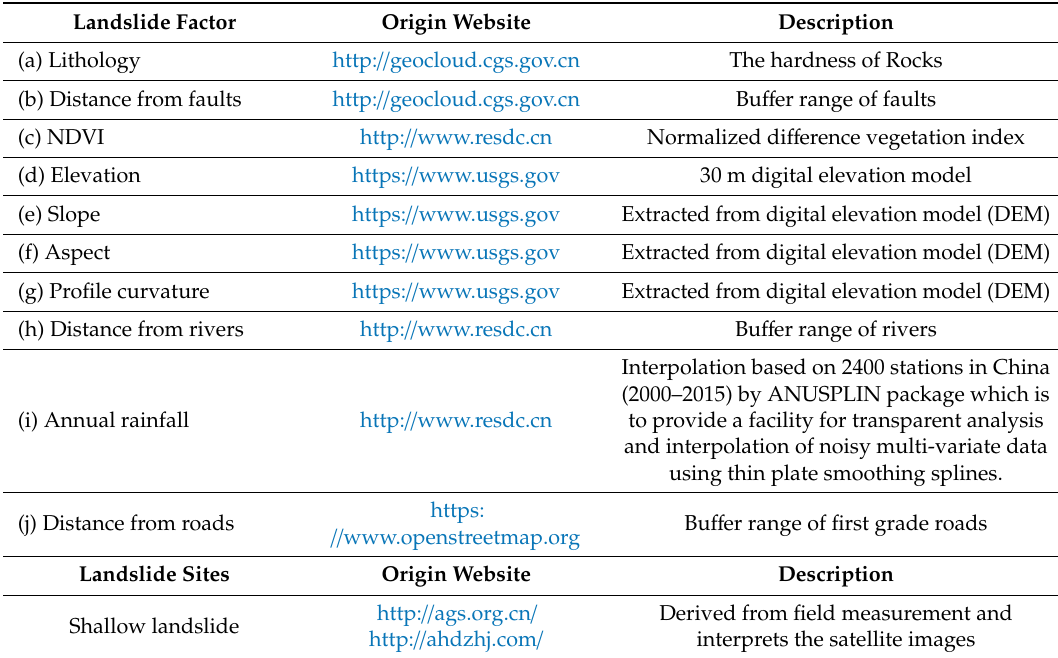
Figure 1. Examples of landslide types in southern Anhui, China: ( a ) landslide in Xuanzhou county, ( b ) landslide in Yuexi county. Table 1. Research data introduction.